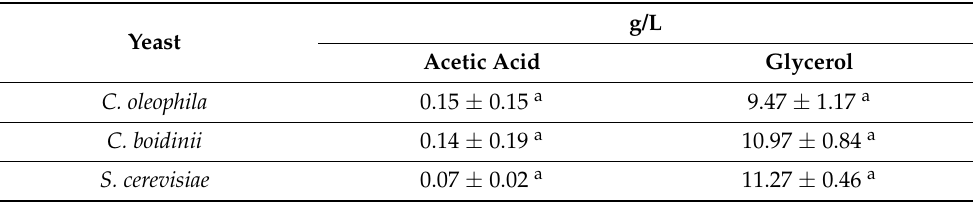
Table 3. Secondary compounds of monoculture fermentations of Sauvignon Blanc from Casablanca Valley (Valpara í so,